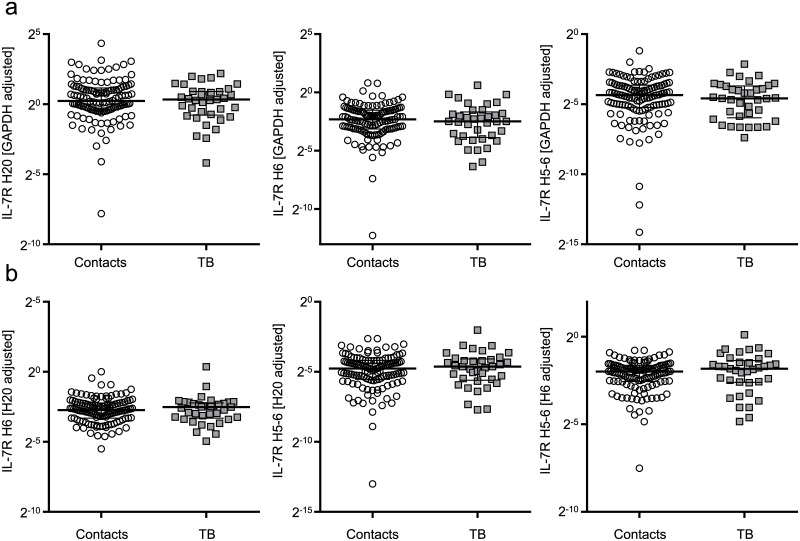
mRNA expression of IL-7R variants of CD4+ T cells from tuberculosis patients and healthy contacts.The expression of full length IL-7R (H20), and IL-7R lacking exon 6 (H6) or exon 5–6 (H5-6) was evaluated using mRNA isolated from CD4+ T cells. (a) Glyceraldehyde 3-phosphate dehydrogenase (GAPDH), or (b) IL-7R variants were applied as references. Cycle threshold differences (2-ΔCt) are shown for tuberculosis patients (n = 37) and healthy contacts (n = 120). Median and interquartile range is depicted, and each symbol indicates mean values of duplicates from each individual donor. Exact Mann-Whitney U test used for comparison of groups.